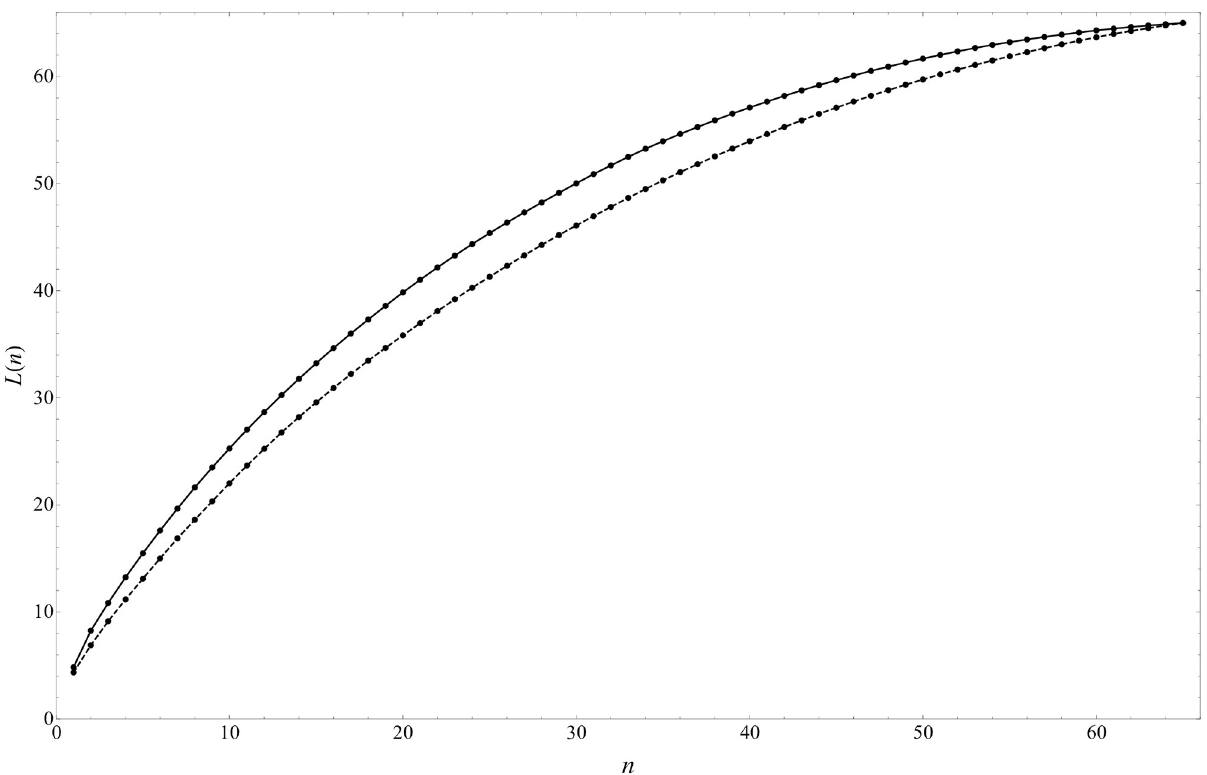
Fig 4. Cumulative eigenvalue L ( n ) defined in Eq (7). This shows how the first n eigenmodes can explain the time-series with respect to the cumulative eigenvalue L ( n ), in other words, the strength of eigenmode (see also Eq